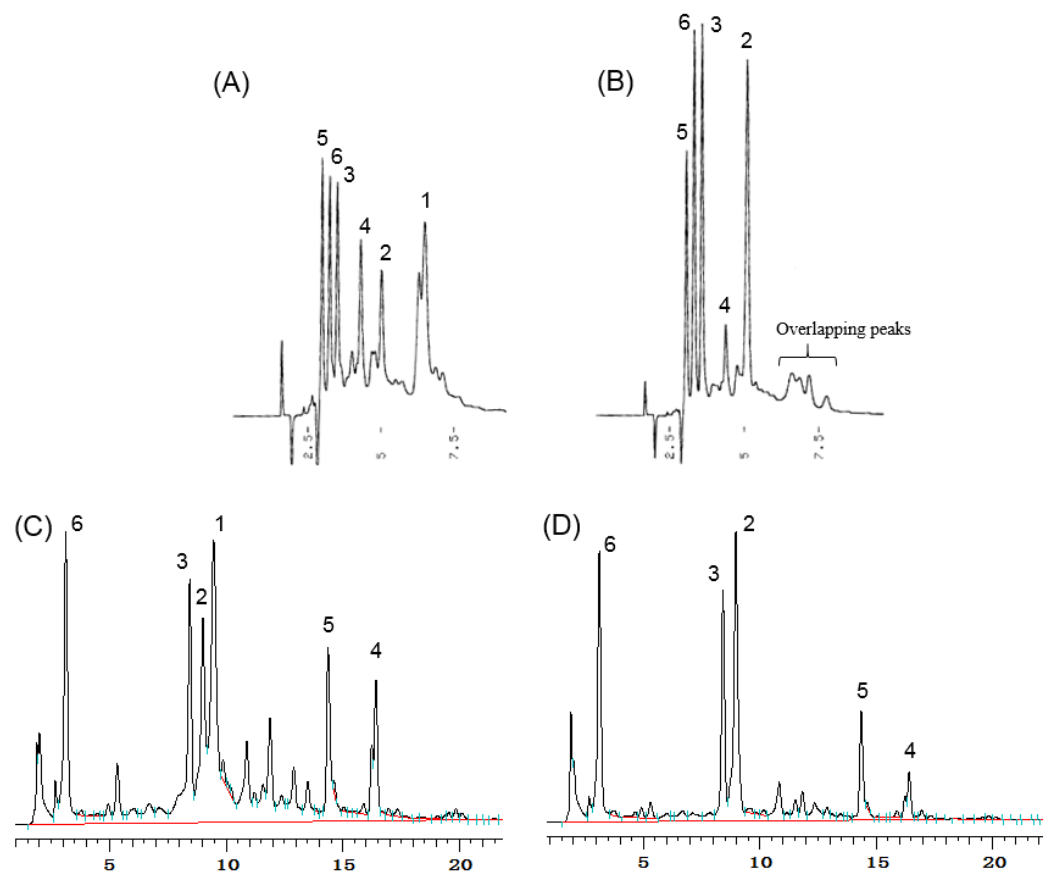
Figure 2. HPLC profiles for the extracts of G. thunbergii : ( A ) short ‐ term decoction on normal phase HPLC; ( B ) long ‐ term decoction on normal phase HPLC; ( C ) short ‐ term decoction on reversed phase HPLC; and ( D ) long ‐ term decoction on reversed phase HPLC.